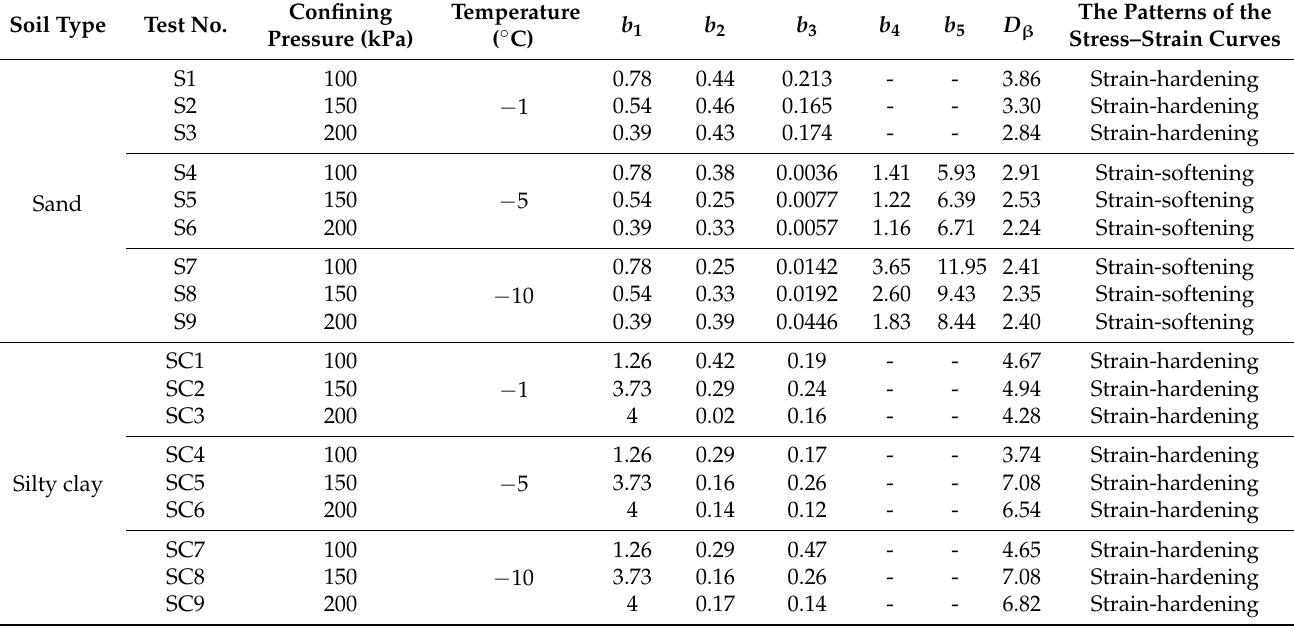
Table 1. Summary of test schemes and the corresponding model